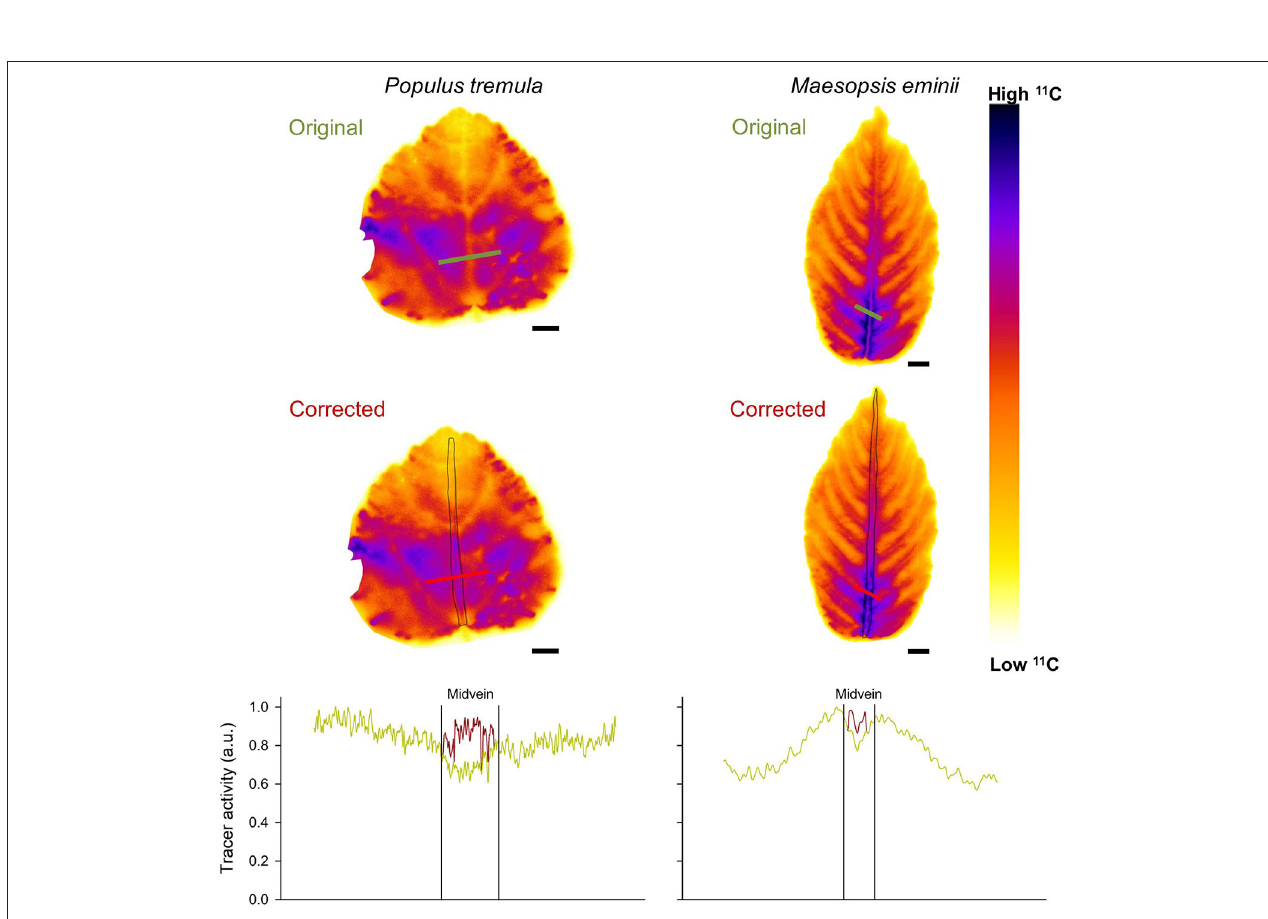
FIGURE 4 | Leaf 11 C-autoradiographs of Populus tremula and Maesopsis eminii . Correction is illustrated for the midvein, with the region enclosed by a black line corrected using the approach of Jødal et al. (2012). The profile plots show how the measured tracer intensity varies in and around the midvein, when corrected (red line) and uncorrected (green line). Tracer activity is expressed in arbitrary units (a.u.) with 1 the maximum intensity measured in the profile. Scale bars are 1cm.